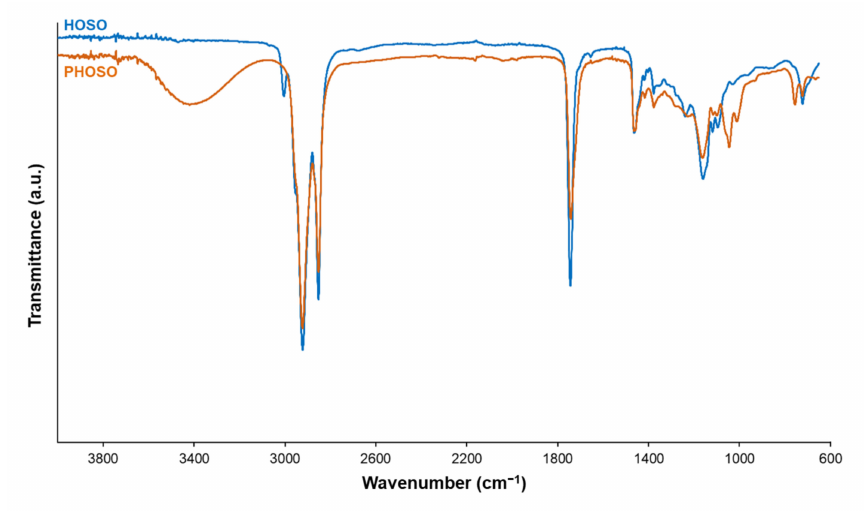
Figure 3. FT-IR spectra of HOSO and PHOSO.